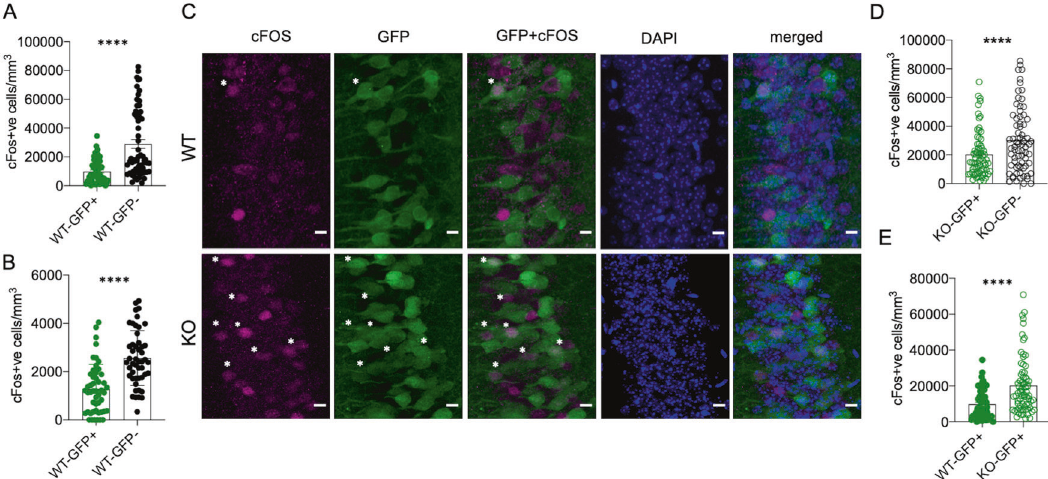
Fig. 2 Tcf4 deletion in adult excitatory neurons increases cFos activity. A , B Quanti fi cation of cFos + cells in GFP + (SEM + / − 1013) versus GFP − (SEM + / − 3001) CA1 neurons ( A ) and granule neurons in DG ( B ), (GFP + : SEM + / − 146.6), (GFP − : SEM + / − 162.7) of wild-type adult animals (~P60 – 90). C Representative images of CA1 neurons showing cFos expression. Asterisks depict cFos + GFP + cells. D Quanti fi cation of cFos + cells in GFP + versus GFP − CA1 neurons of Tcf4-KO brain, (GFP + : SEM + / − 1887), (GFP − : SEM + / − 2677). E Quanti fi cation of cFos + cells in GFP + CA1 neurons from WT and KO brains, (WT: SEM + / − 1013), (KO: SEM + / − 1887) (each dot represents a brain section, ~10 sections per brain were quanti fi ed, CA1: 7 WT, 8 KO and DG: 5 WT, 5 KO animals), Wilcoxon test, **** p < 0.0001, error bar represents SEM. Analysis was done 3 weeks post deletion. Scale bar = 10